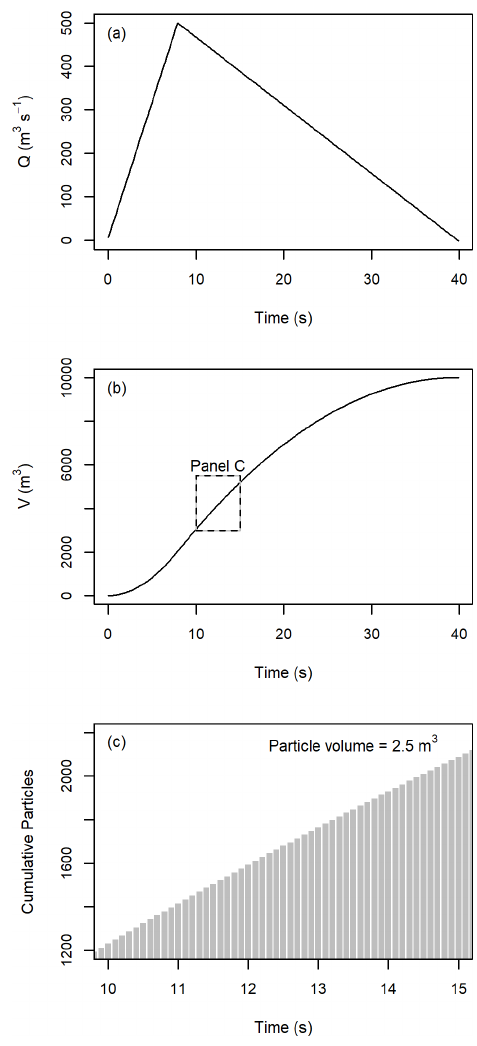
Figure A1. (a) Input hydrograph, (b) cumulative volume in the model versus time, and (c) discretization of the cumulative volume into simulation particles for the portion of the time series indicated in (b)